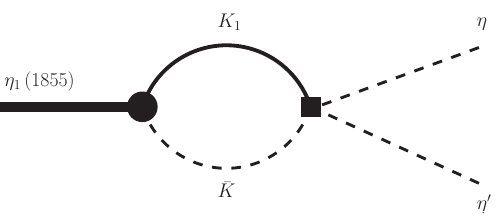
Figure 3. Diagram corresponding to the η 1